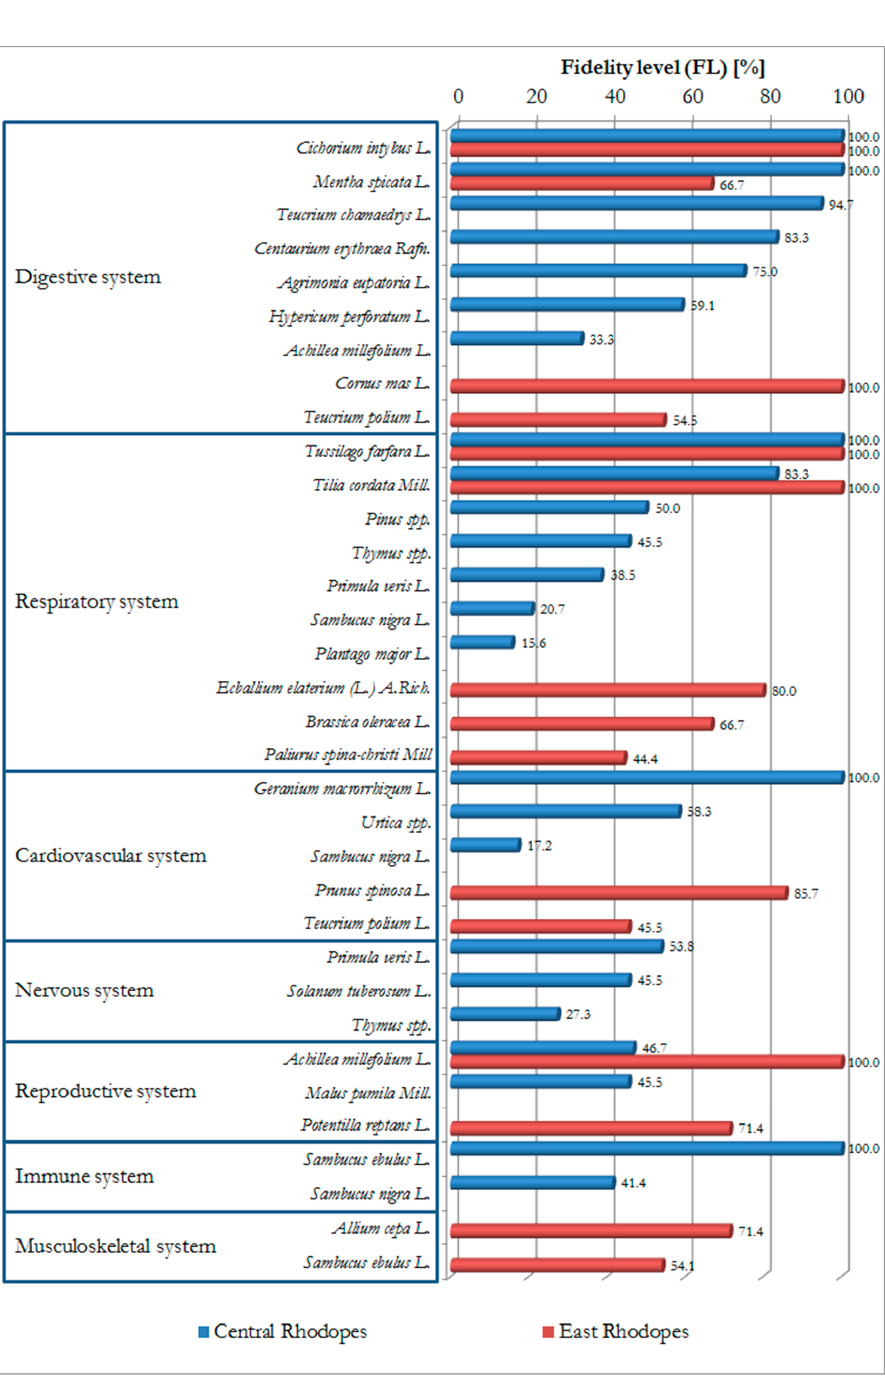
Figure 8. Comparision of di ff erent diseases categories by FL index . Achillea millefolium had an FL value equal to 100% for the East Rhodopes and only 46.7% for the Central Rhodopes in the female reproductive system treatment category. This indicates that all informants who reported A. millefolium in the East Rhodopes